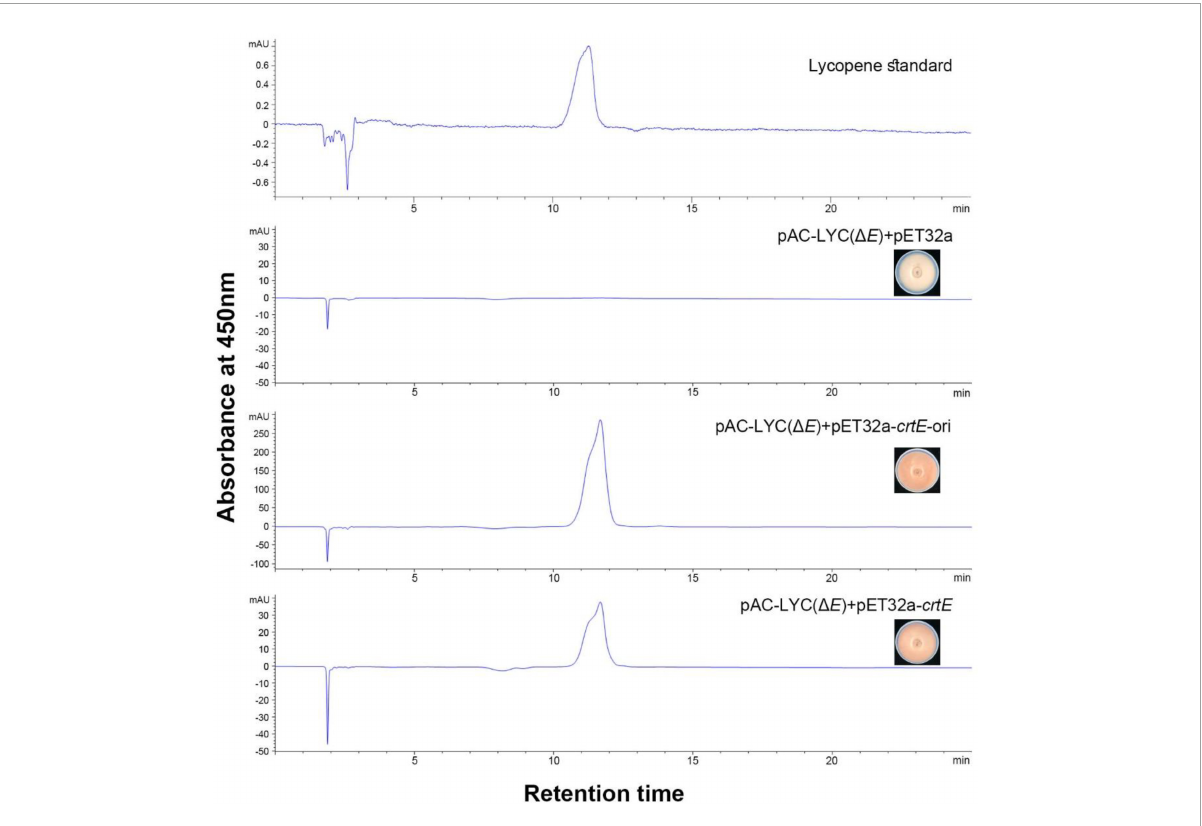
FIGURE6 HPLC analysis of carotenoid production of E. coli carrying different plasmids. Pigment detection was performed by monitoring absorption at 450